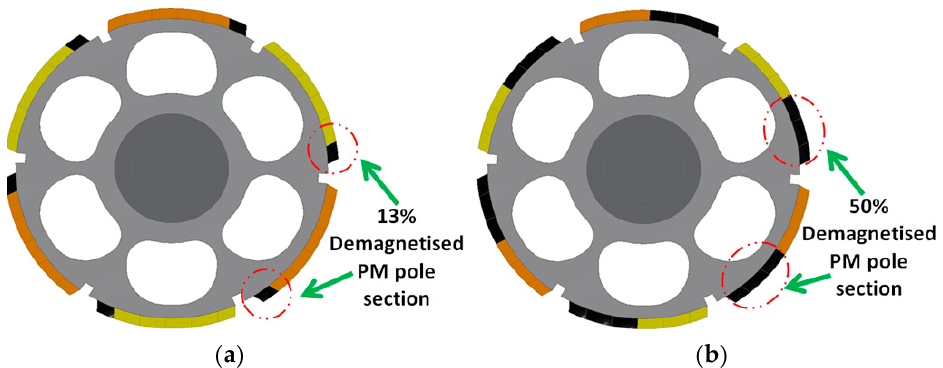
Figure 2. Uniform symmetrical demagnetized rotors: rotor with F13 ( a ) and rotor with F50 ( b ).